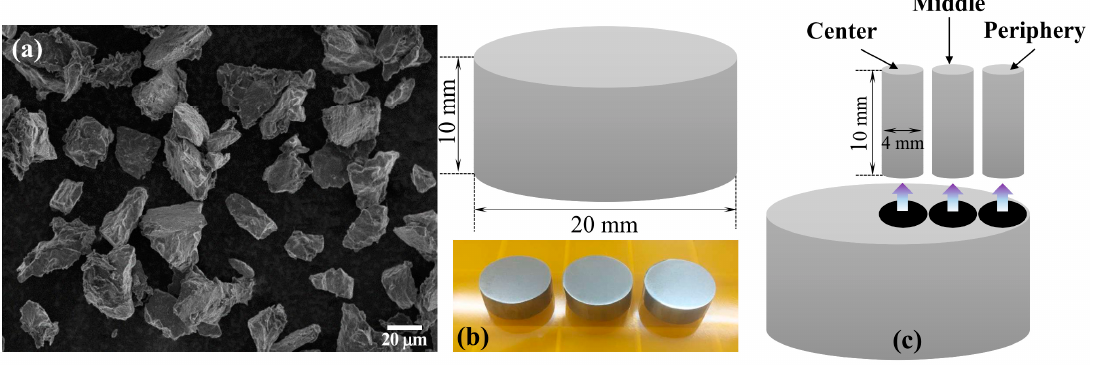
Figure 2. ( a ) SEM image of Ti6Al4V powder, ( b ) optical picture of Ti6Al4V alloy after sintering, and ( c ) schematic of cutting process for the test specimen.